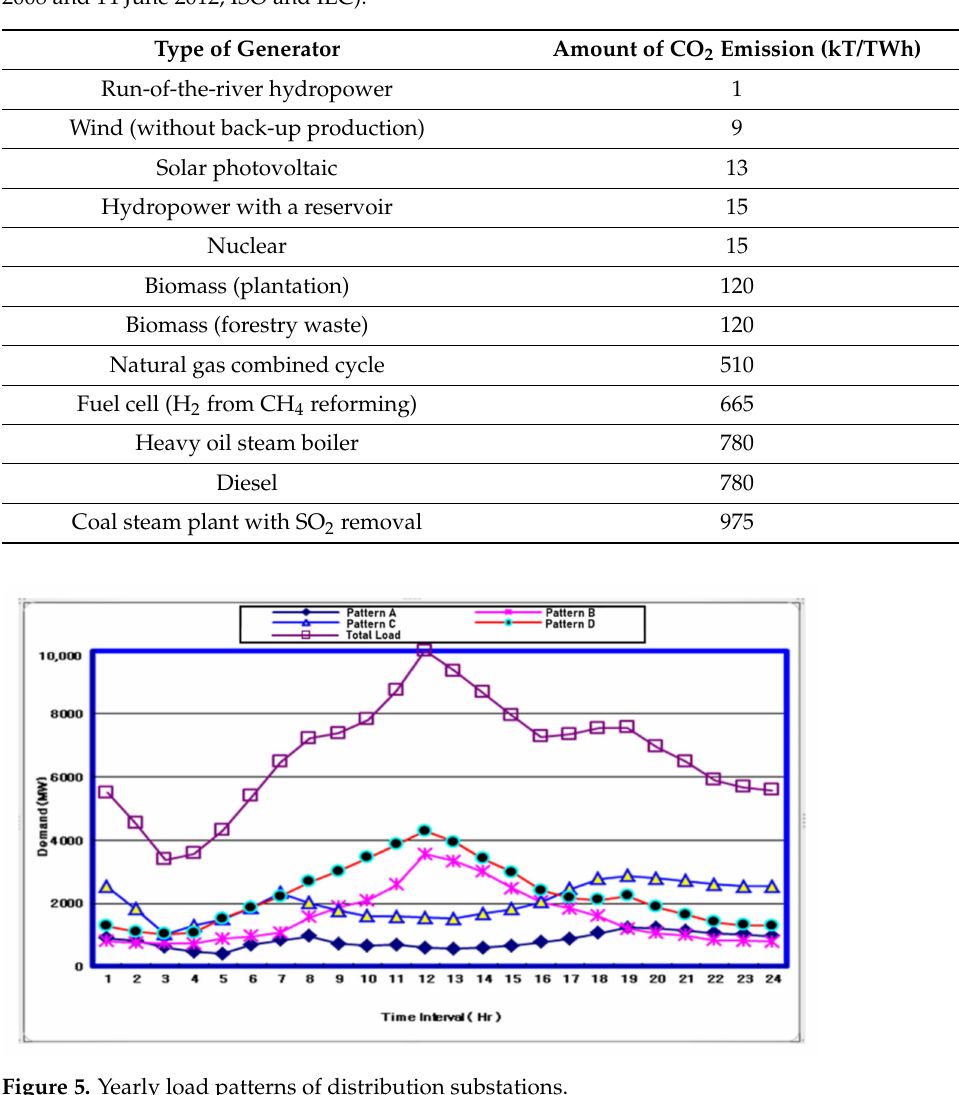
Figure 5. Yearly load patterns of distribution